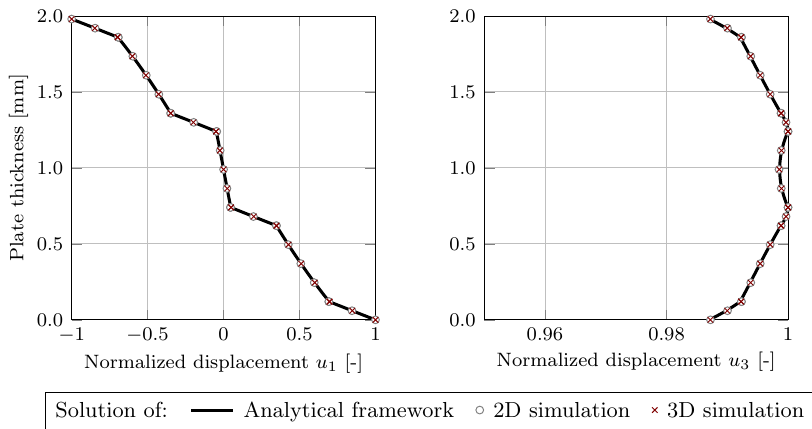
Figure A1. In-plane ( left ) and out-of-plane ( right ) components of a normalized displacement field for A 0 wave mode perpendicular to the fiber orientation at 80kHz derived from the analytical framework and numerical 2D- and 3D-simulations.